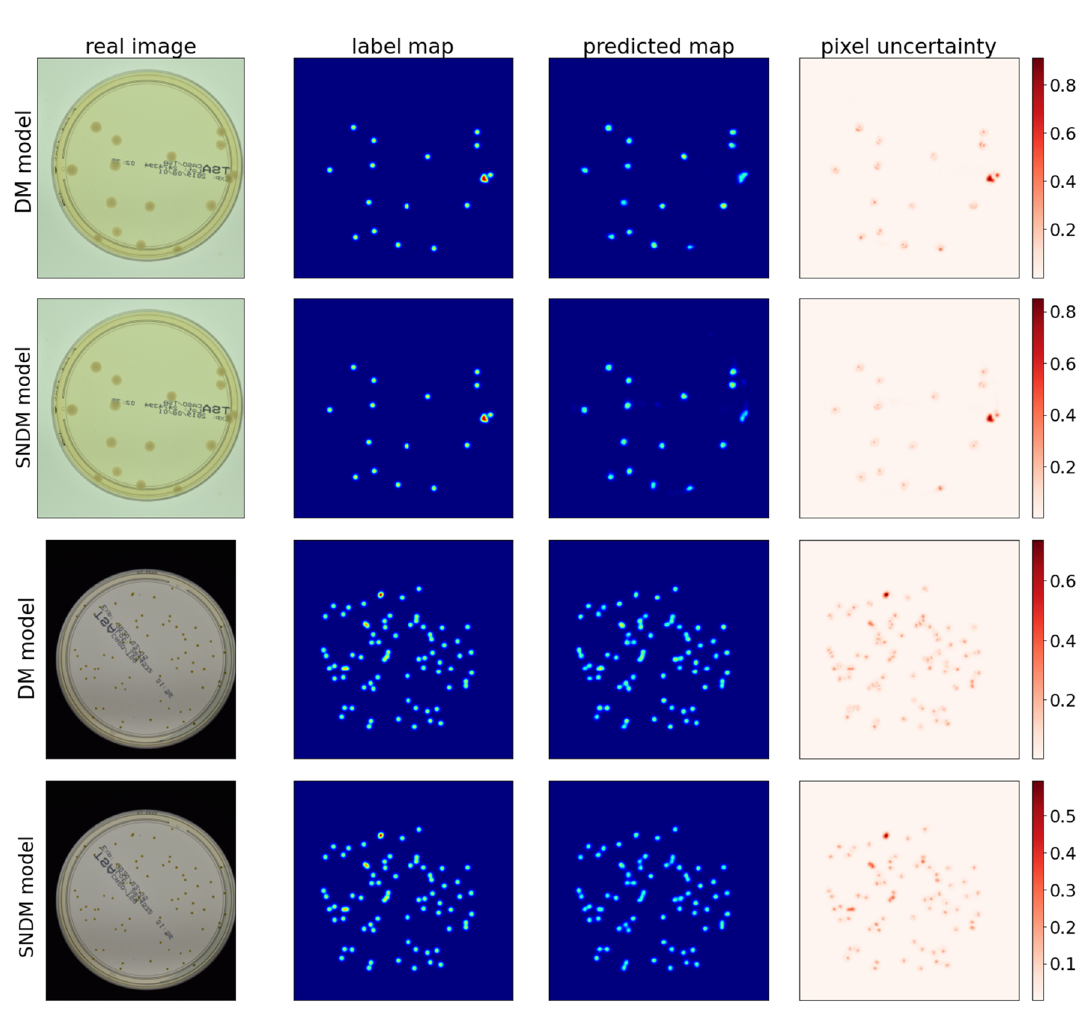
Figure 7. Examples of density maps for two exemplary input images from the test subset (with 16 and 72 labelled colonies), together with their uncertainties per pixel: the DM model (rows 1st and 3rd), and the SNDM model (rows 2nd and 4th). In the first case DM model predicts 17 ± 0.99 , while SNDM predicts 16 ± 0.44 colonies. In the second case DM predicts 63 ± 3.32 , and the SNDM predicts 71 ± 1.57 colonies. Uncertainty maps calculated using MC dropout